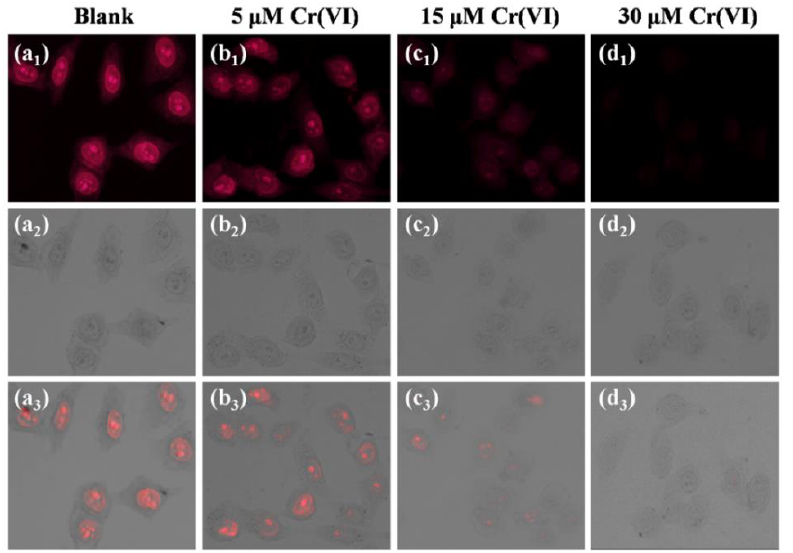
Figure 6. Fluorescent microscopy images ( a 1 – d 1 ), bright-field transmission images ( a 2 – d 2 ) and their overlay images ( a 3 – d 3 ) of Hela cells. Cells were treated with R-CDs ( a 1 ), and cells were treated with R-CDs and then incubated with different concentrations Cr(VI) ( b 1 , c 1 , d 1 ).